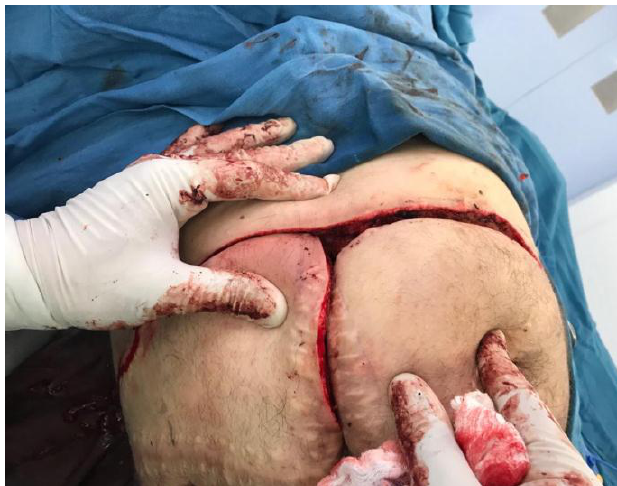
Figure 3: Hemostasis with covering and securing of internal defect